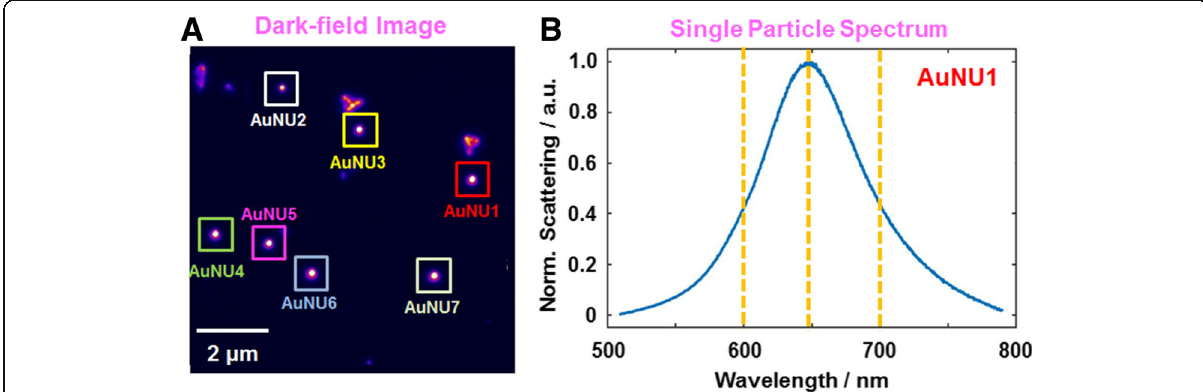
Fig. 2 a DF scattering image of 90 nm AuNUs deposited on a glass slide. b Single particle scattering spectrum of AuNU1 highlighted with a red square in a . A single LSPR peak was observed around 650 nm for the AuNU1. The yellow-dotted lines indicate the incident LSPR wavelengths (600 nm, 640 nm, 700 nm) used in this